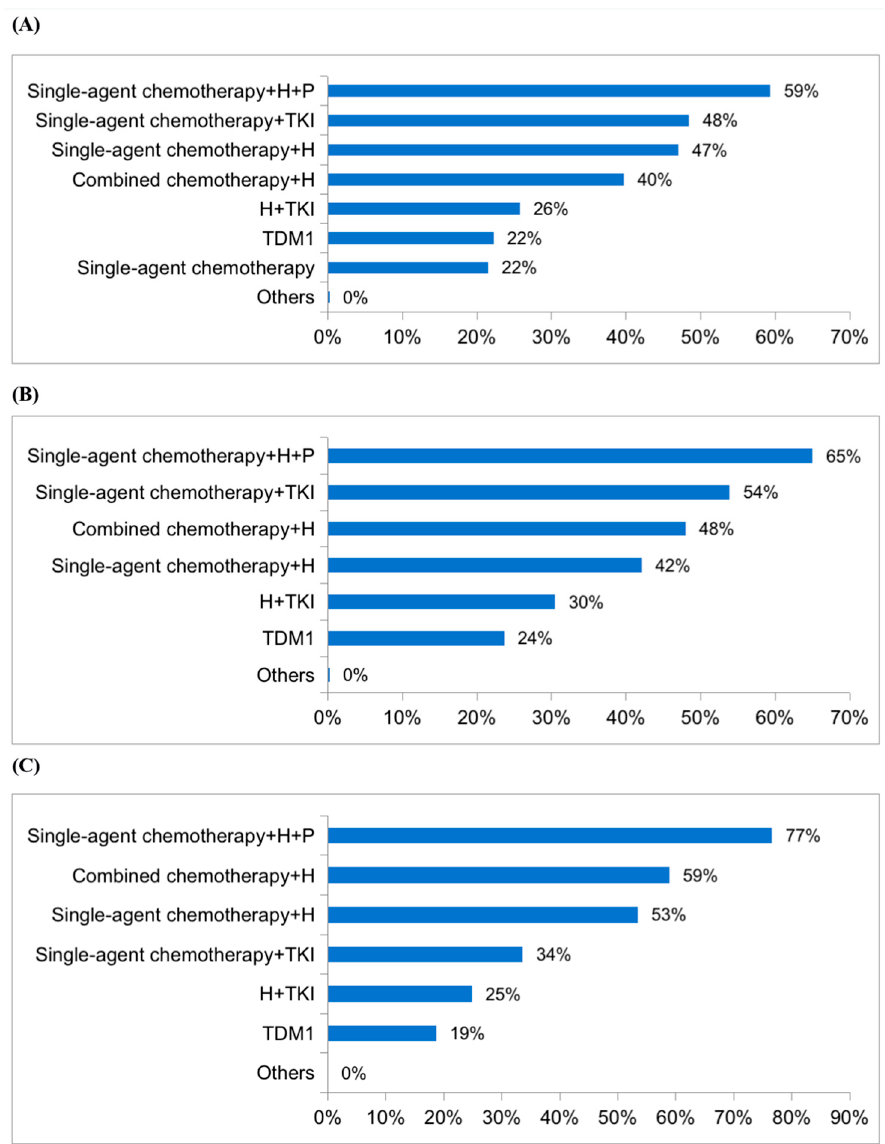
Figure 4. The first-line treatment regimens chosen by 423 doctors for HER2-positive MBC patients who received trastuzumab in neoadjuvant or adjuvant treatment: ( A ) DFI < 6 months; ( B ) 6 months ≤ DFI ≤ 12 months; ( C ) DFI > 12 months.